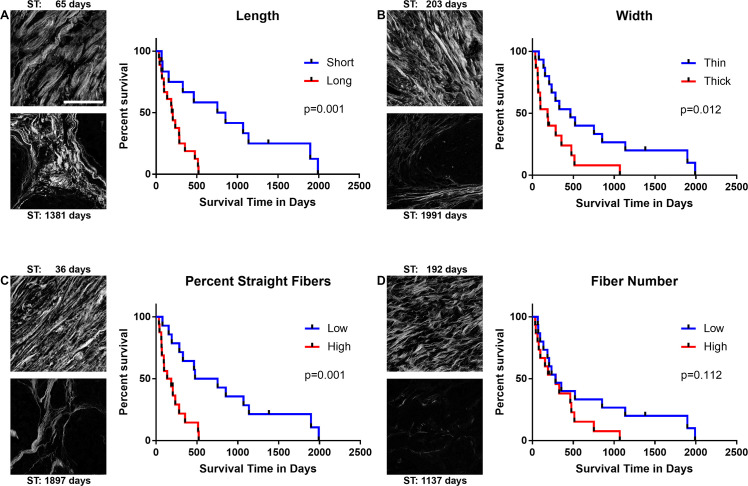
Collagen fiber characteristics in feline mammary carcinoma biopsies predict survival.Collagen fiber characteristics were quantified using data analysis software (CT-FIRE). Data were compared to ST using Kaplan-Meier survival curves, comparing lower than the mean and higher than the mean groups for collagen fiber (A) length, (B) width, (C) straightness, and (D) number. Univariate cox regression was used to evaluate whether the collagen fiber parameters significantly impacted survival (length: p = 0.001, hazard ratio 4.597, 95%CI 1.849–11.428; width: p = 0.012, hazard ratio 2.650, 95%CI 1.242–5.654; straightness: p = 0.001, hazard ratio 4.390, 95%CI 1.890–10.197; number: p = 0.112, hazard ratio 1.827, 95%CI 0.869–3.838). For each parameter, example SHG images with survival times are shown from the low and high groups. All images in figure are at the same scale. Scale bar: 100μm.